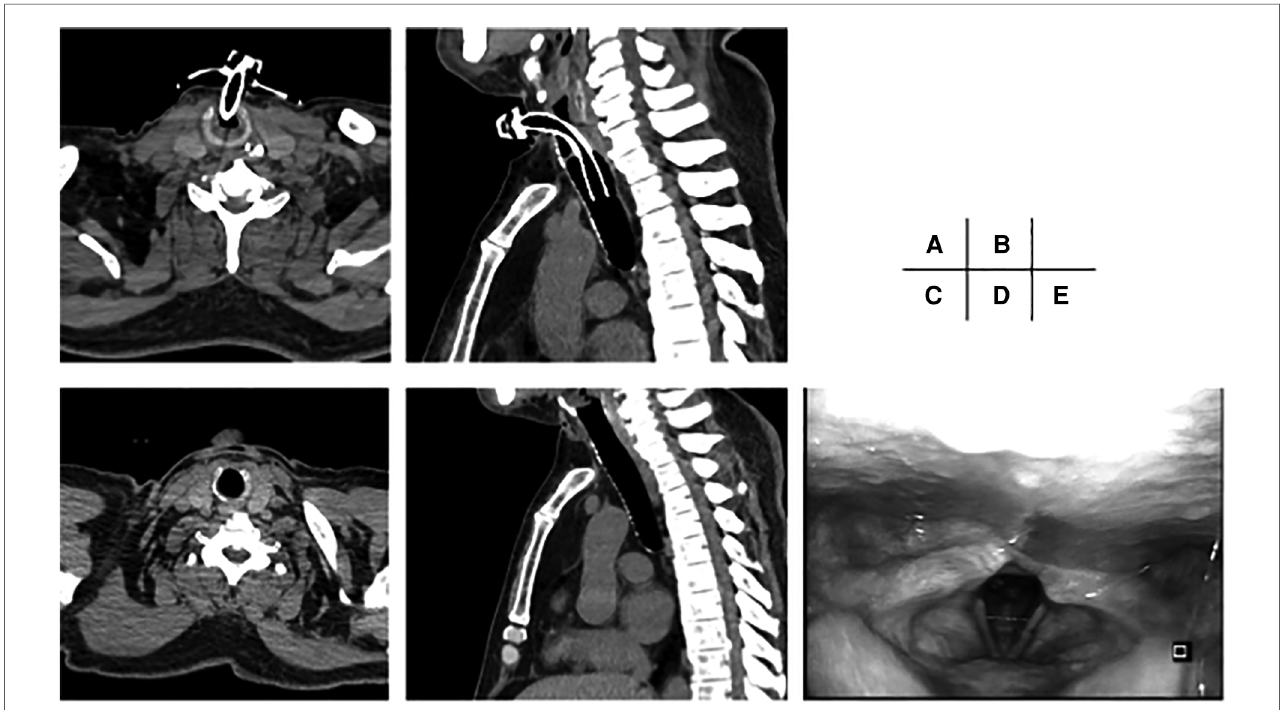
FIGURE 2 Ct scans and endoscopic image of larynx before and after decannulation. ( A,B ): CT scan before decannulation. The cannula is inserted at the level of the cricoid cartilage. ( C,D ): CT scan three months after decannulation. No stenosis is observed. ( E ): Endoscopic image of larynx three months after decannulation. No laryngeal stenosis is